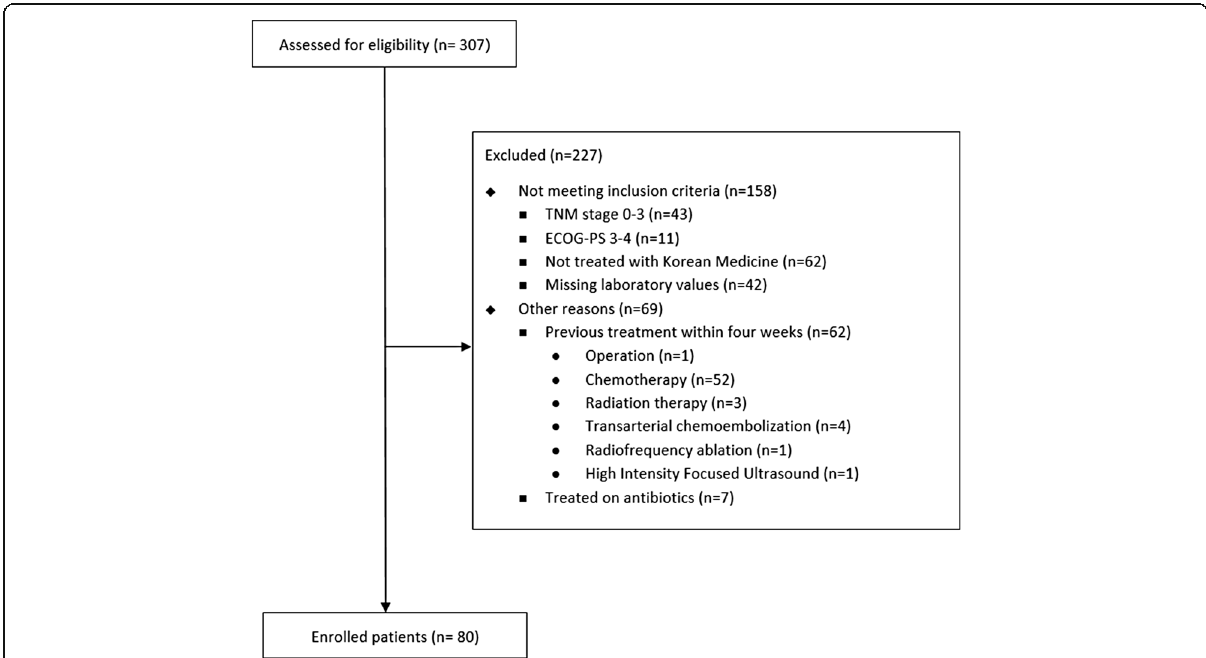
Fig. 1 Flow chart of status of patients with advanced hepatobiliary